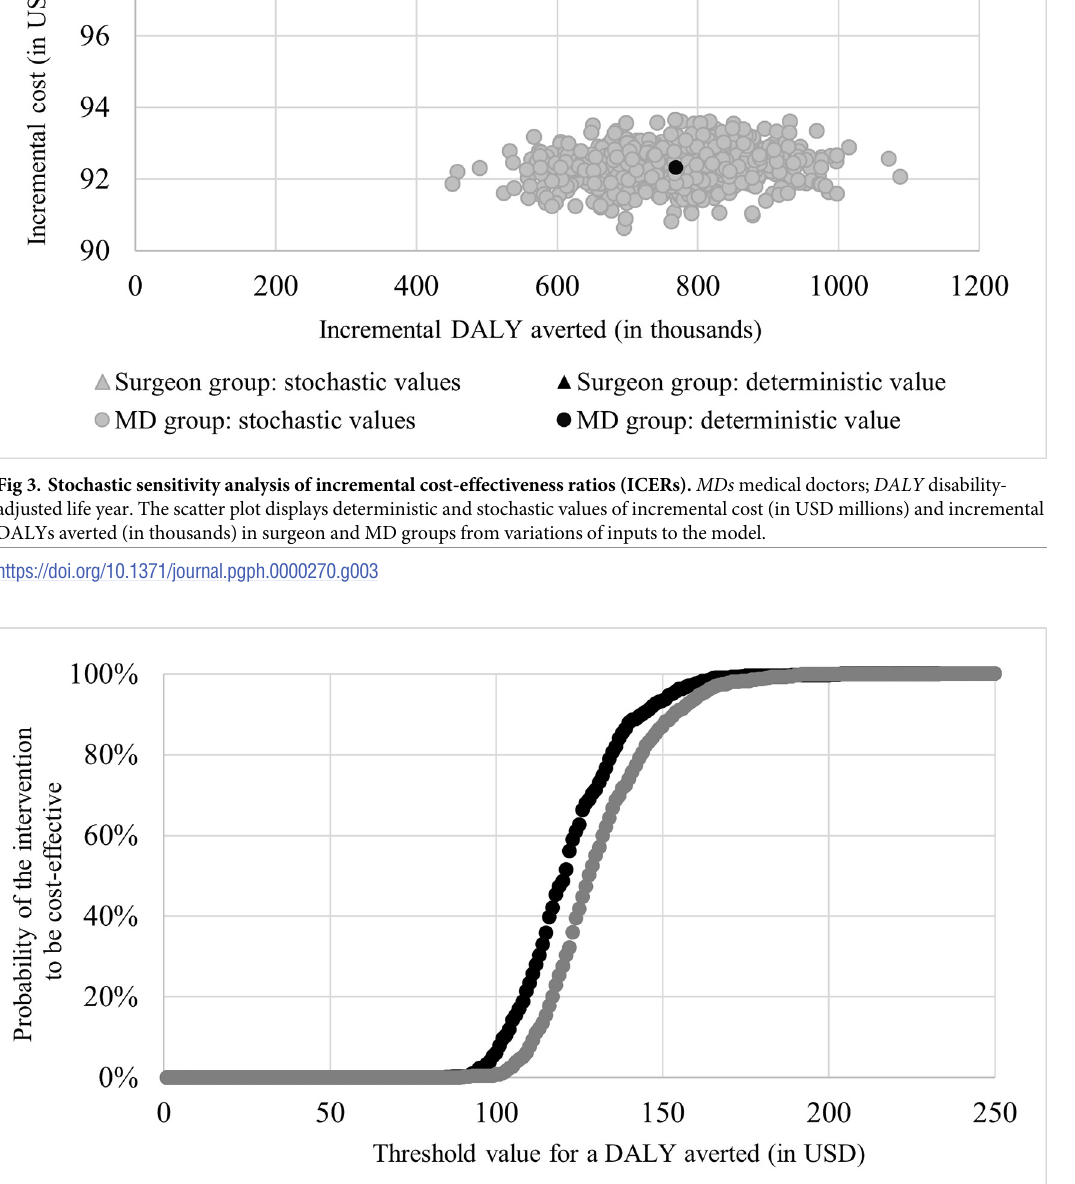
PLOS Global PublicHealth | https://doi.org/10.1371/journal.pgph.0000270 April 4,